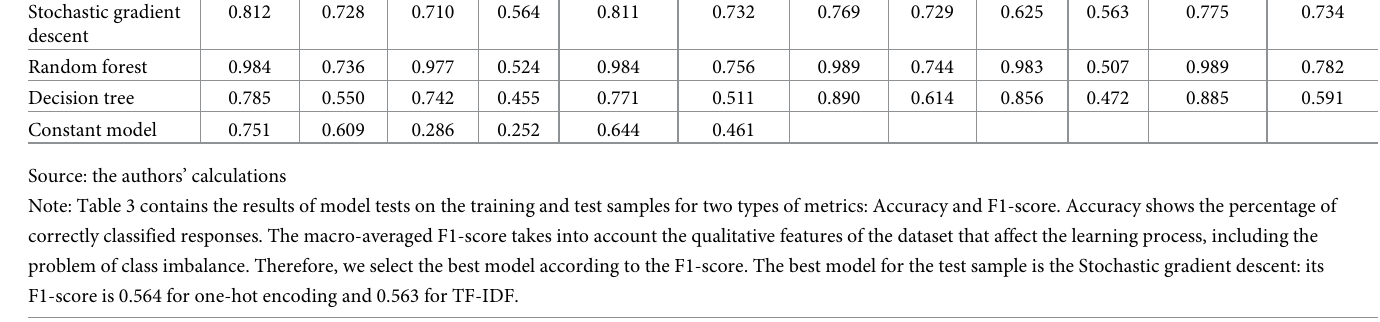
Stochastic gradient descent Random